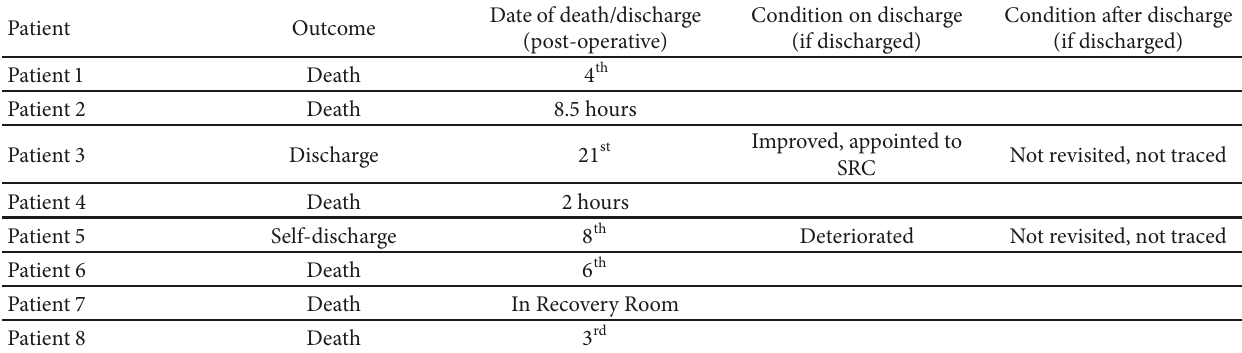
Table 1: Postoperative outcome of patients diagnosed with FGPD of unknown